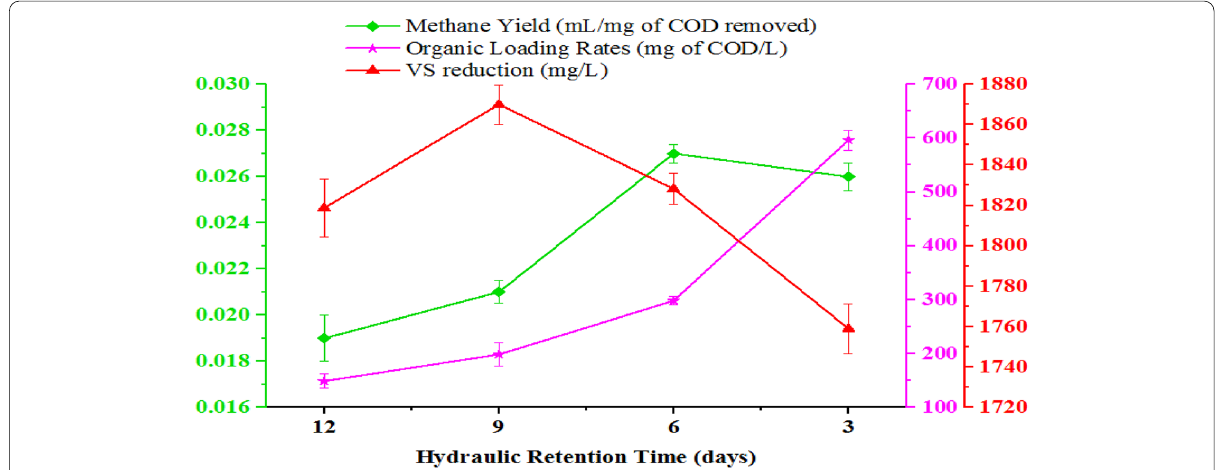
Fig. 9 Variations of biogas production, methane and carbon dioxide percentage of methanogenesis reactor at different